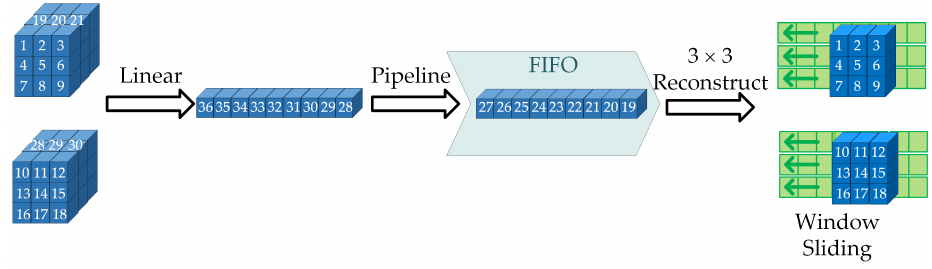
Figure 10. The processing flow of the weight transfer scheme.